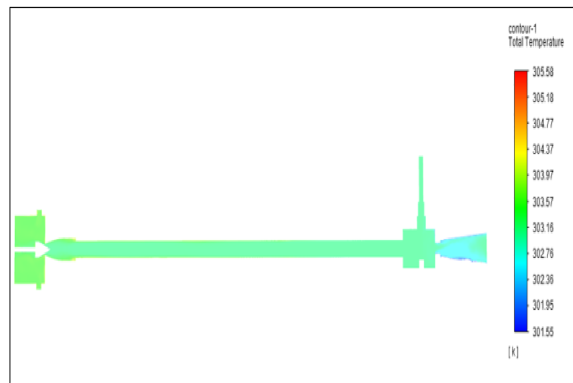
Figure 6. CPVC at 2 bar.